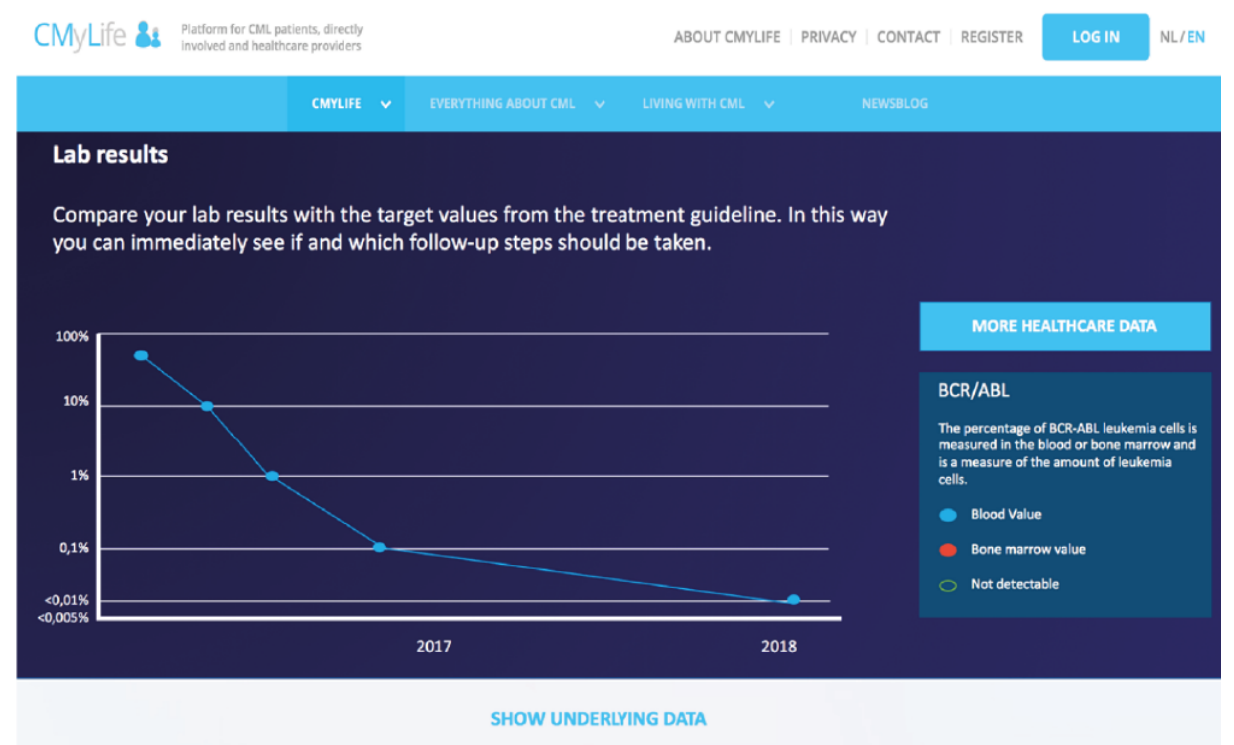
Figure 4. Screenshot of the graph depicting BCR-ABL1 transcript values in a patient’s own Patients Know Best record in the CMyLife environment. When a dot is selected, it shows the results and its